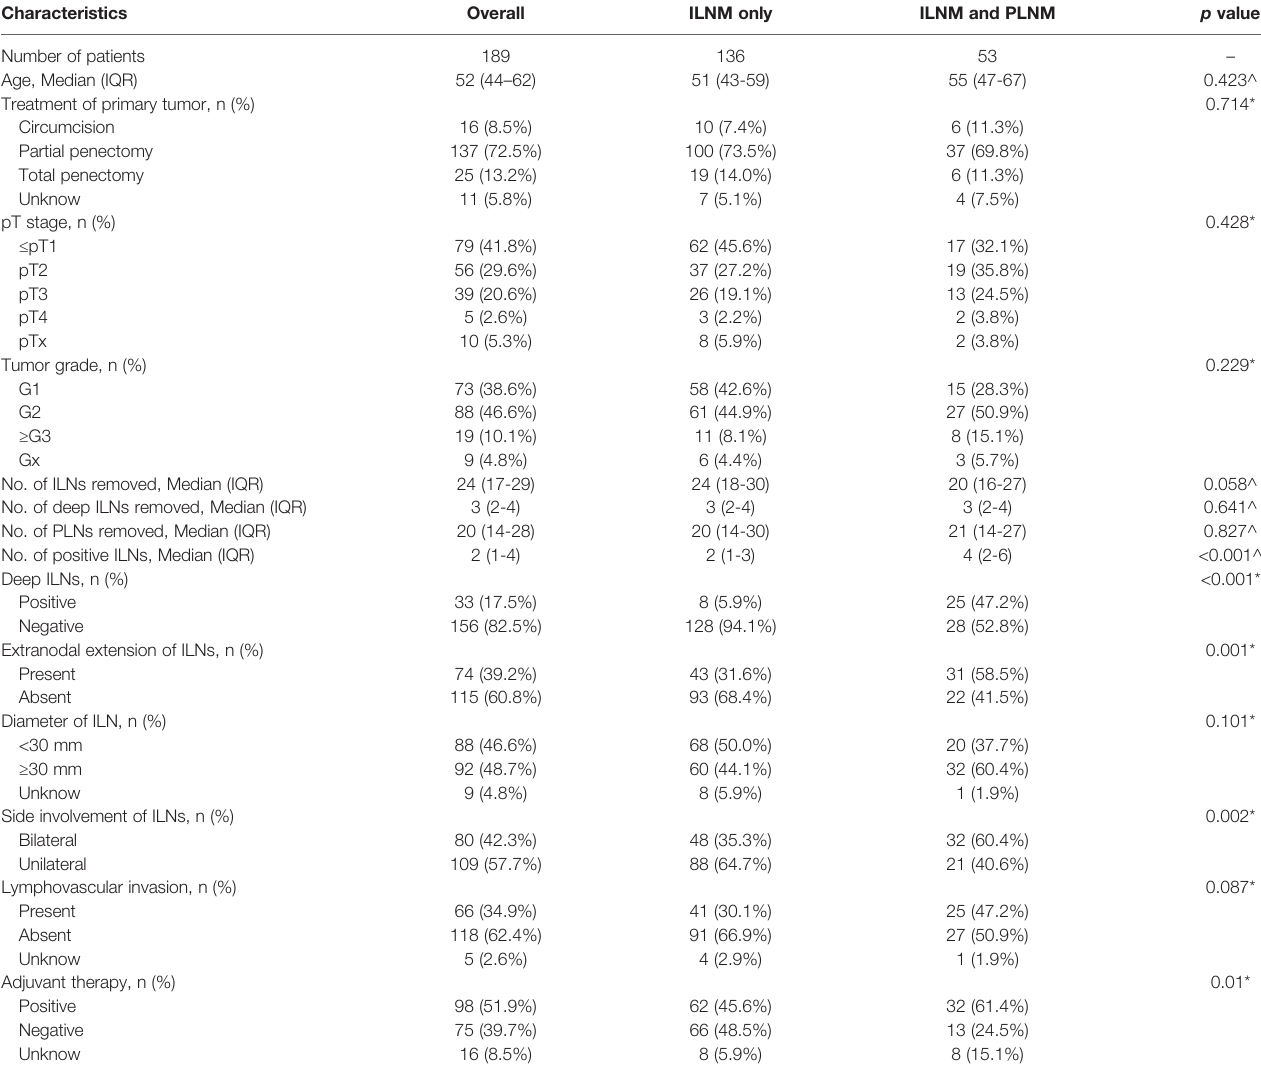
TABLE 1 | Clinical and pathological characteristics of the 189 patients with penile SCC.